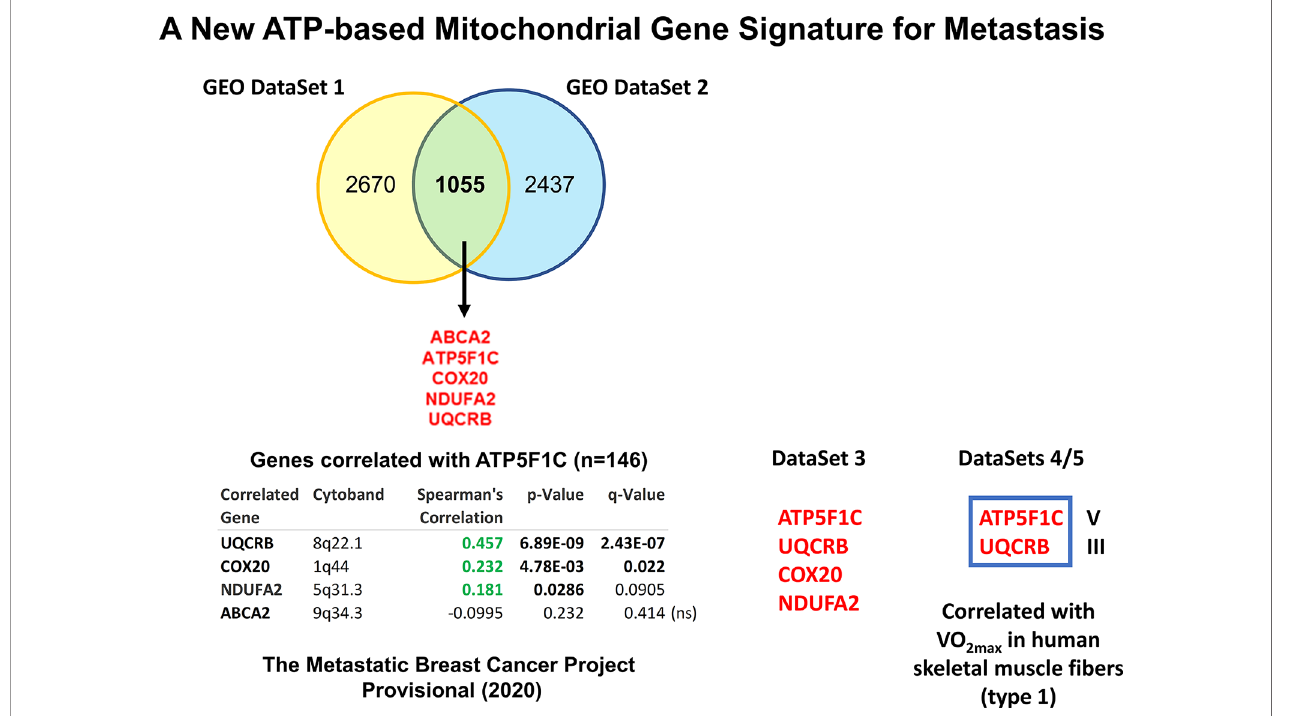
FIGURE 4 | Using several independent data sets to identify ATP5F1C as a key biomarker and therapeutic target for metastasis prevention. In order to de fi ne an ATP-related metastasis gene signature we fi rst intersected two GEO DataSets focused on breast cancer metastasis (namely, GSE2034 and GSE59000), resulting in 5 common genes. The positive co-expression of ATP5F1C, with 3 other members of this gene signature (UQCRB, COX20, NDUFA2), was indeed con fi rmed by analyzing data from The Metastatic Breast Cancer Project (Provisional, February 2020; DataSet 3; https://mbcproject.org). Finally, 2 of these 4 gene transcripts (ATP5F1C and UQCRB) were independently found to be speci fi cally-associated with i) maximal oxygen uptake (VO 2max ) and ii) a higher percentage of mitochondrial-rich (type 1) fi bers, in human skeletal muscle (DataSets 4/5), especially during exercise training. Therefore, ATP5F1C and UQCRB are likely to be key biomarkers of high OXPHOS and high mitochondrial ATP production in cancer cells. Modi fi ed from Reference 33 and reproduced with permission, under a Creative Commons License